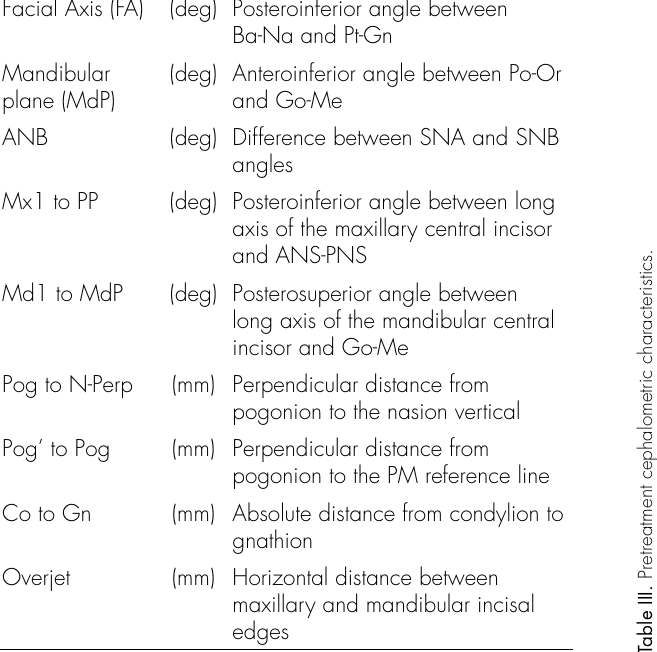
Table II. Cephalometric